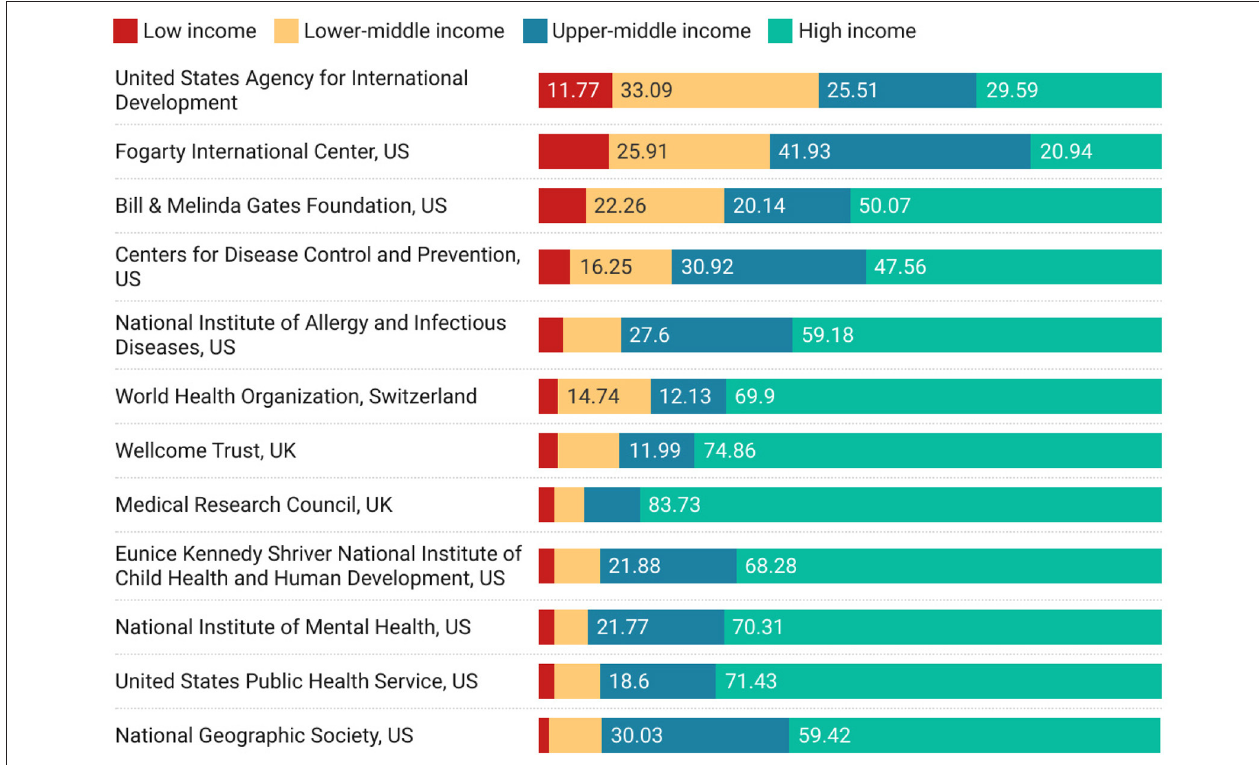
FIGURE 8 | Funding acknowledged in papers co-authored between high-income countries and lower income groups, ordered by proportion of low-income